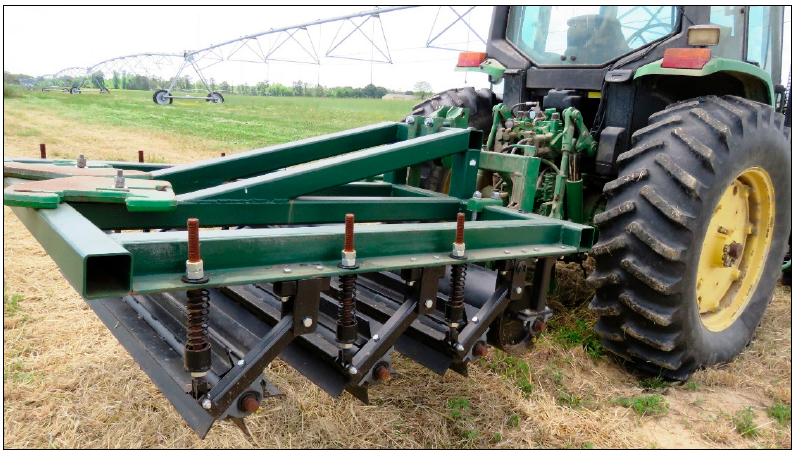
Figure 2. Four ‐ stage roller/crimper [28], US patent number: 7,987,917 B1.